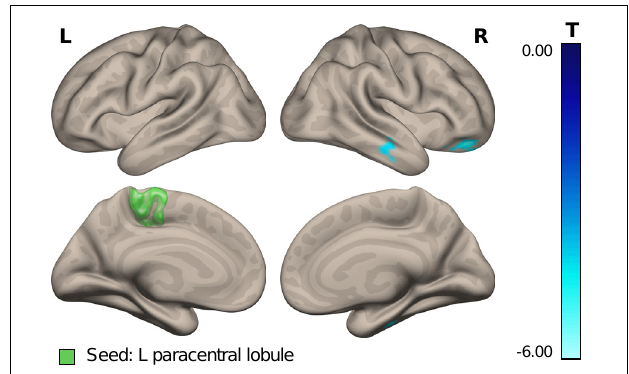
FIGURE 6 | Connectivity of the paracentral lobule. Areas demonstrating altered functional connectivity with the left paracentral lobule evoked by plantar stimulation over the resting baseline in cosmonauts compared to the control group, at post- vs. pre-flight. Blue indicates decreasing connectivity with the seed. Green indicates the location of the